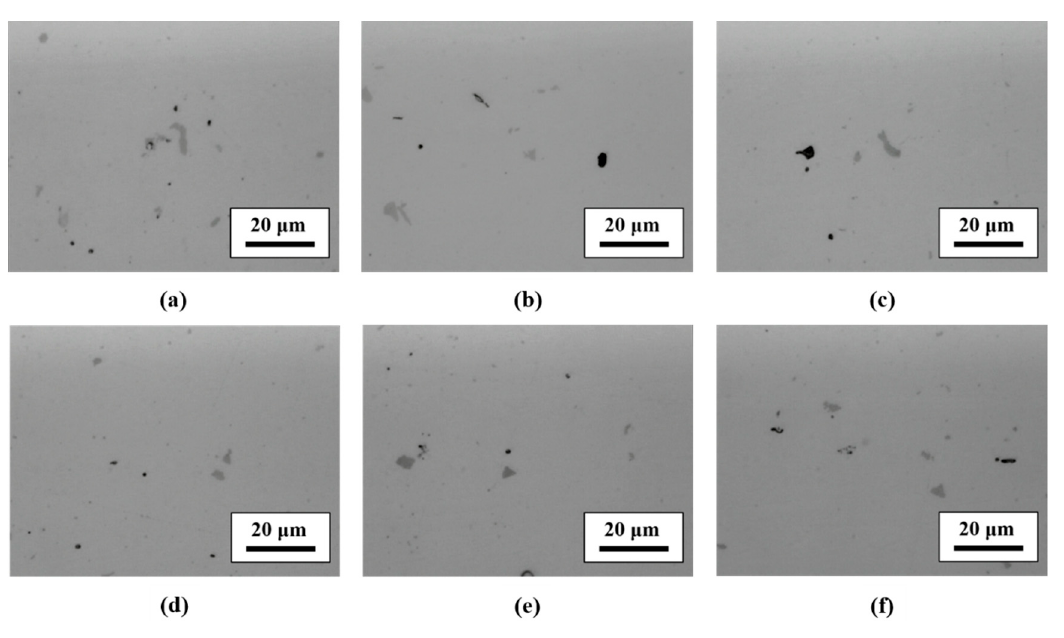
Figure 3. Diagram of the tensile test specimens.